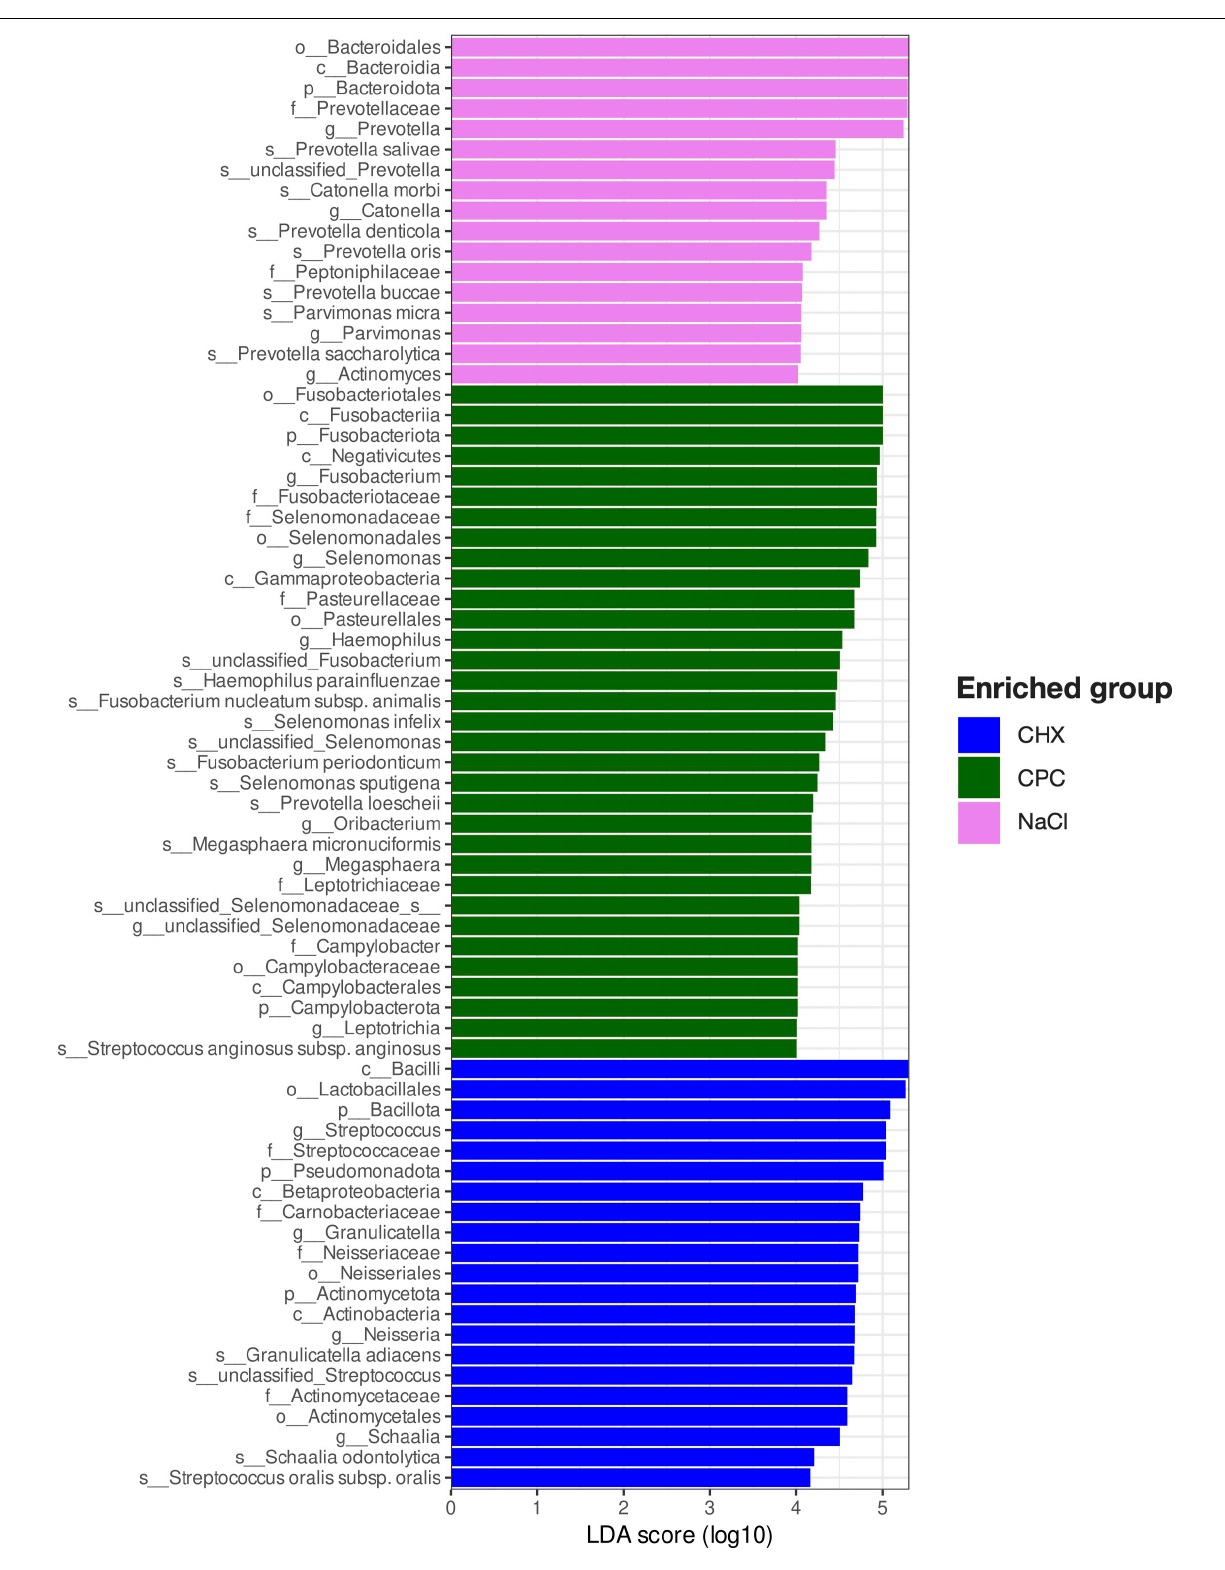
Frontiers in Microbiology |